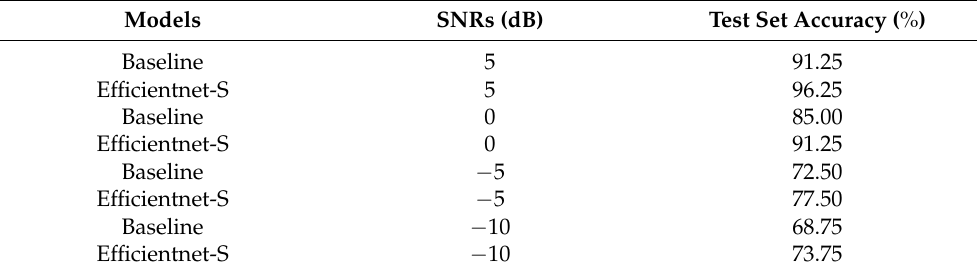
Figure 5. Scaling the model under different SNRs. Table 2. Experimental results based on the baseline and Efficientnet-S under different